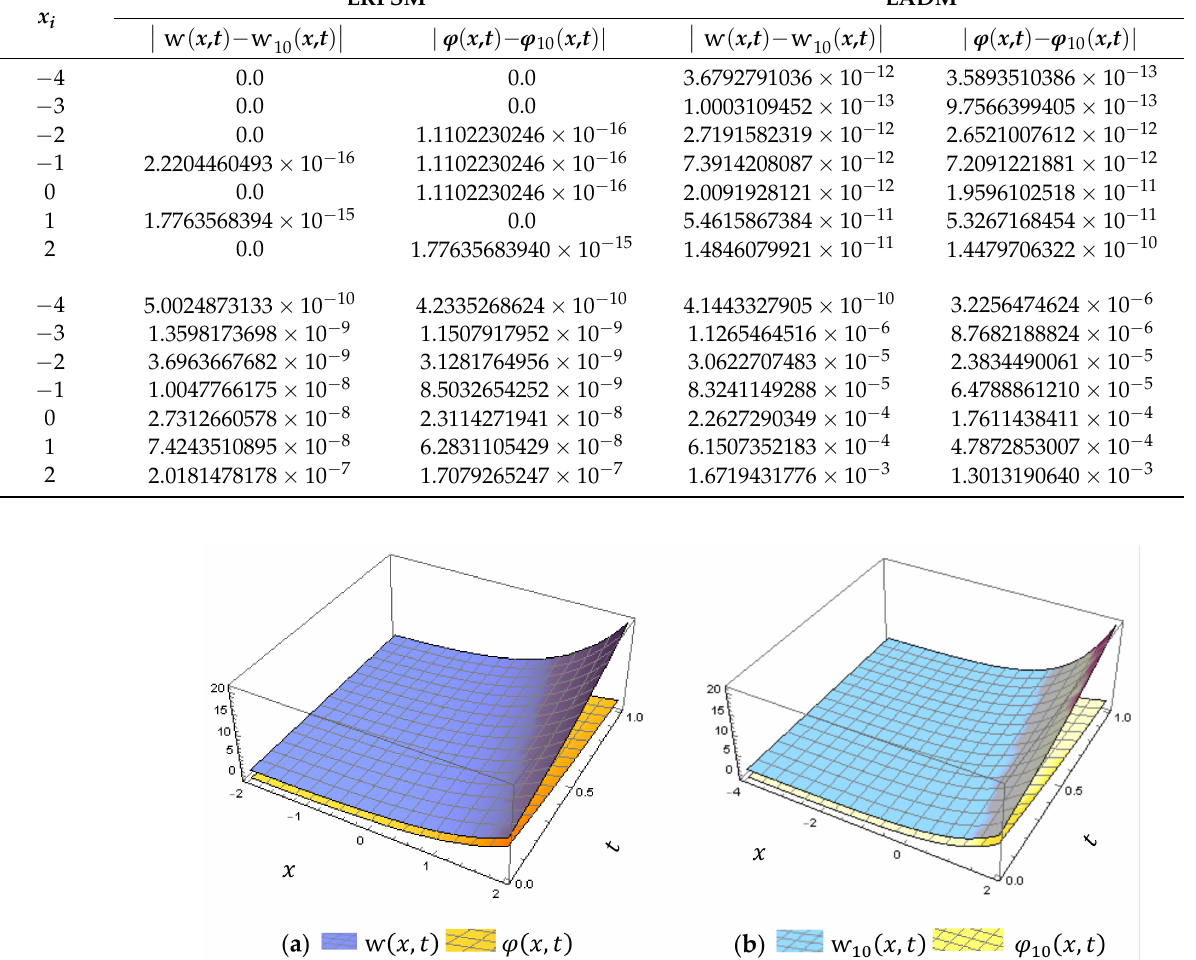
Figure 1. ( a ) 3D-surfaces plot of exact